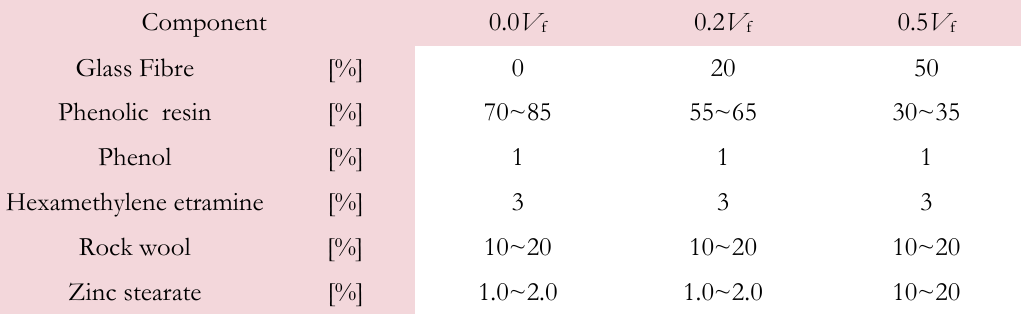
Table 1: Configuration of SGP material.